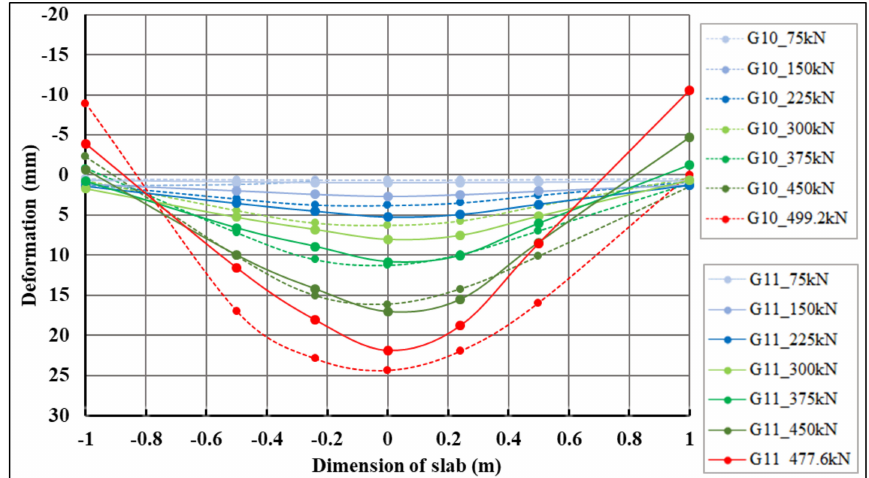
Figure 15. Comparison of 2D cross-deformation sections of centrically loaded slab G10 and eccentri- cally loaded slab G11 for track sensors 23|23*–29|29*. Table 7. Deformation of centrically loaded slab G10 and eccentrically loaded slab G11 for track sensors 23|23*–29|29*.